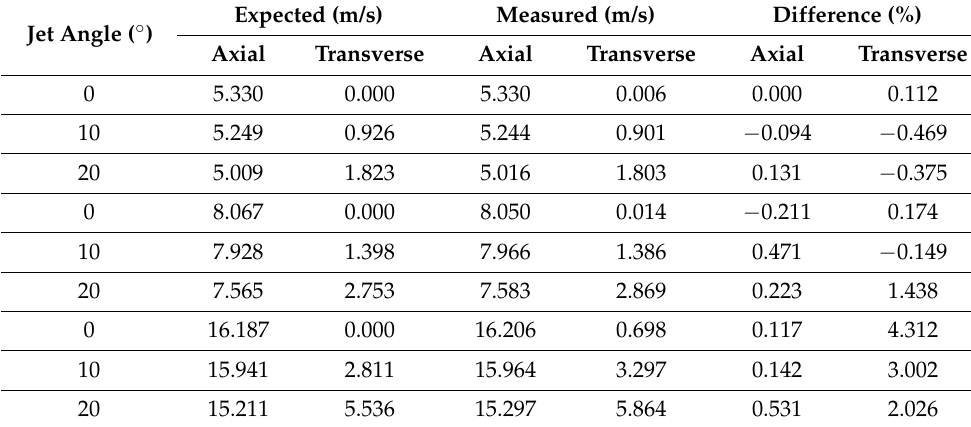
Figure 10. Velocity decomposition of water flow injected by nozzle. Table 2. Comparison of measured and expected velocity components.